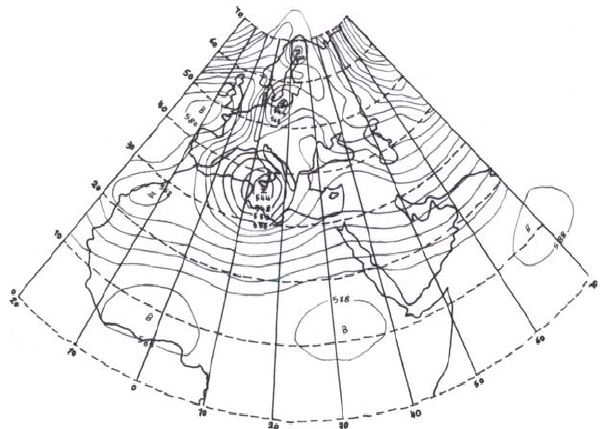
Fig. 14 The pattern of the surface (AAXX) Siberian and Azores isobars 48 hours Fig. 14. The pattern of the surface (AAXX) Siberian and Azores Fig. 15 The pattern of the streamlines and the LA center at 500 hPa 48 hours before Fig. 15. The pattern of the streamlines and the LA center at 500hPa isobars 48h before the rainfalls (type IV: 30 December 1984). 48h before the rainfalls (type IV: 30 December 1984). before the rainfalls (Type IV: 30 December 1984) the rainfalls (Type IV: 30 December 1984)